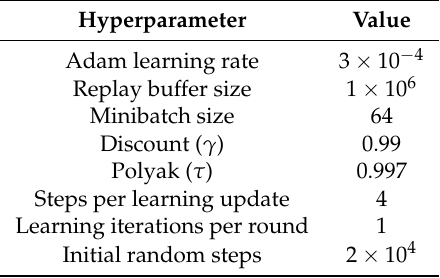
Table A1. Hyperparameters used for SAC-Discrete.